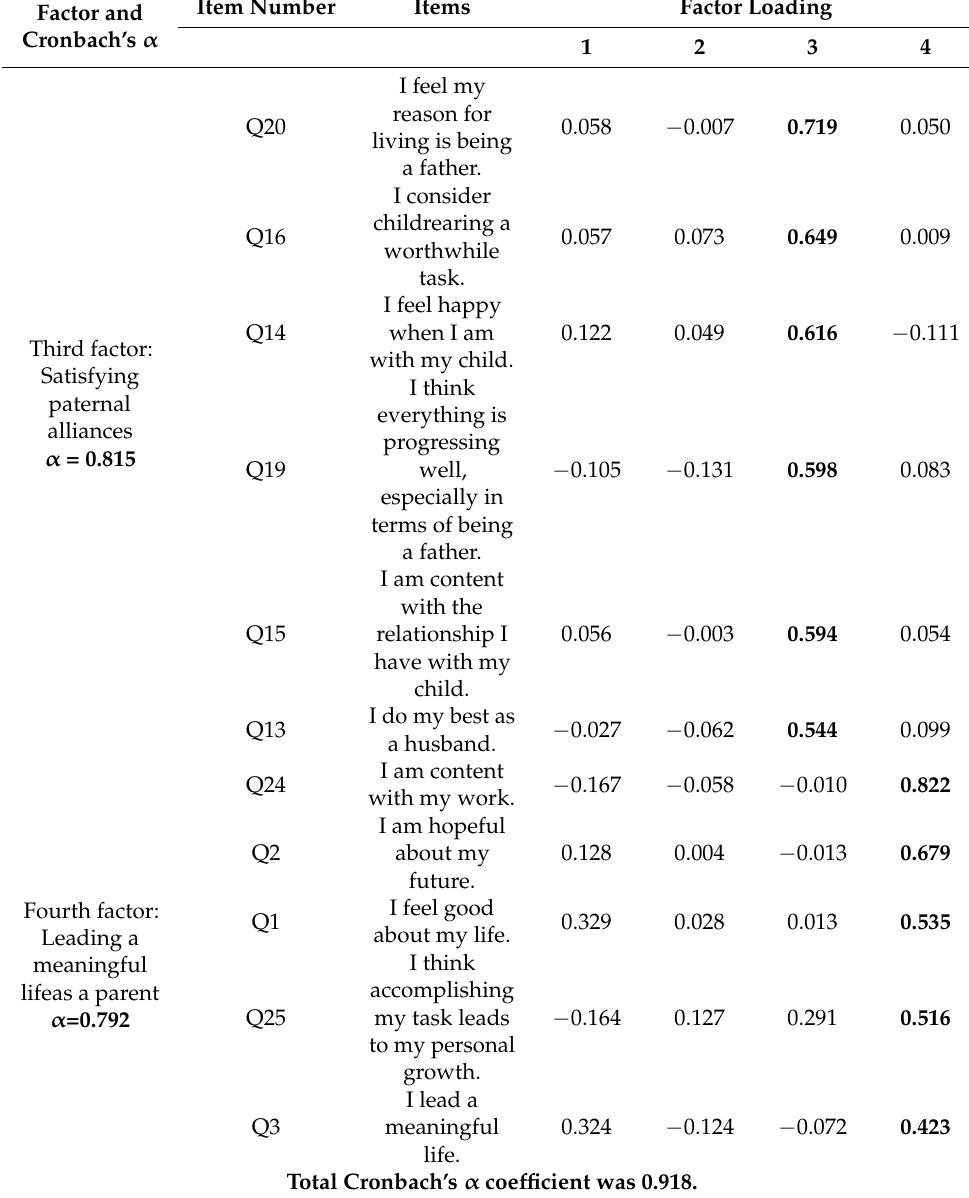
Table 3. Cont. Factor